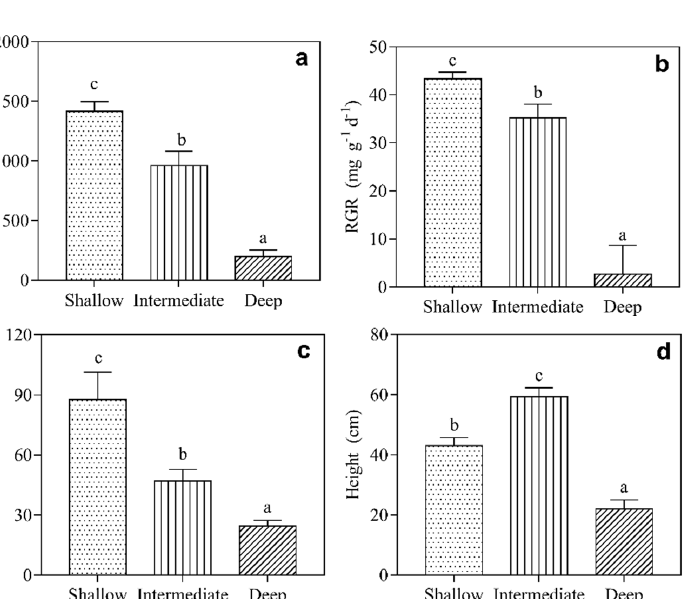
Figure 1. Comparisons of ( a ) biomass (g m − 2 ), ( b ) RGR (mg g − 1 d − 1 ), ( c ) plant numbers (ind. mesocosm − 1 ), and ( d ) plant height (cm) of V. natans among three water depth groups. Values represent mean ± SD (n = 4). Means with different letters are significantly different ( p < 0.05). Water depth significantly affected the biomass, RGR, and plant branch numbers of H. verticillata (Table 2; Figure 2a–c). The biomass, RGR, and plant branch numbers were notably lower in the deep water group than in the shallow and intermediate water groups. However, there was no significant difference between shallow and intermediate water depths (Table 2; Figure 2a–c). In addition, water depth also notably affected the height of H. verticillata . As the water depth increased, the height of H. verticillata increased (Table 2; Figure 2d).